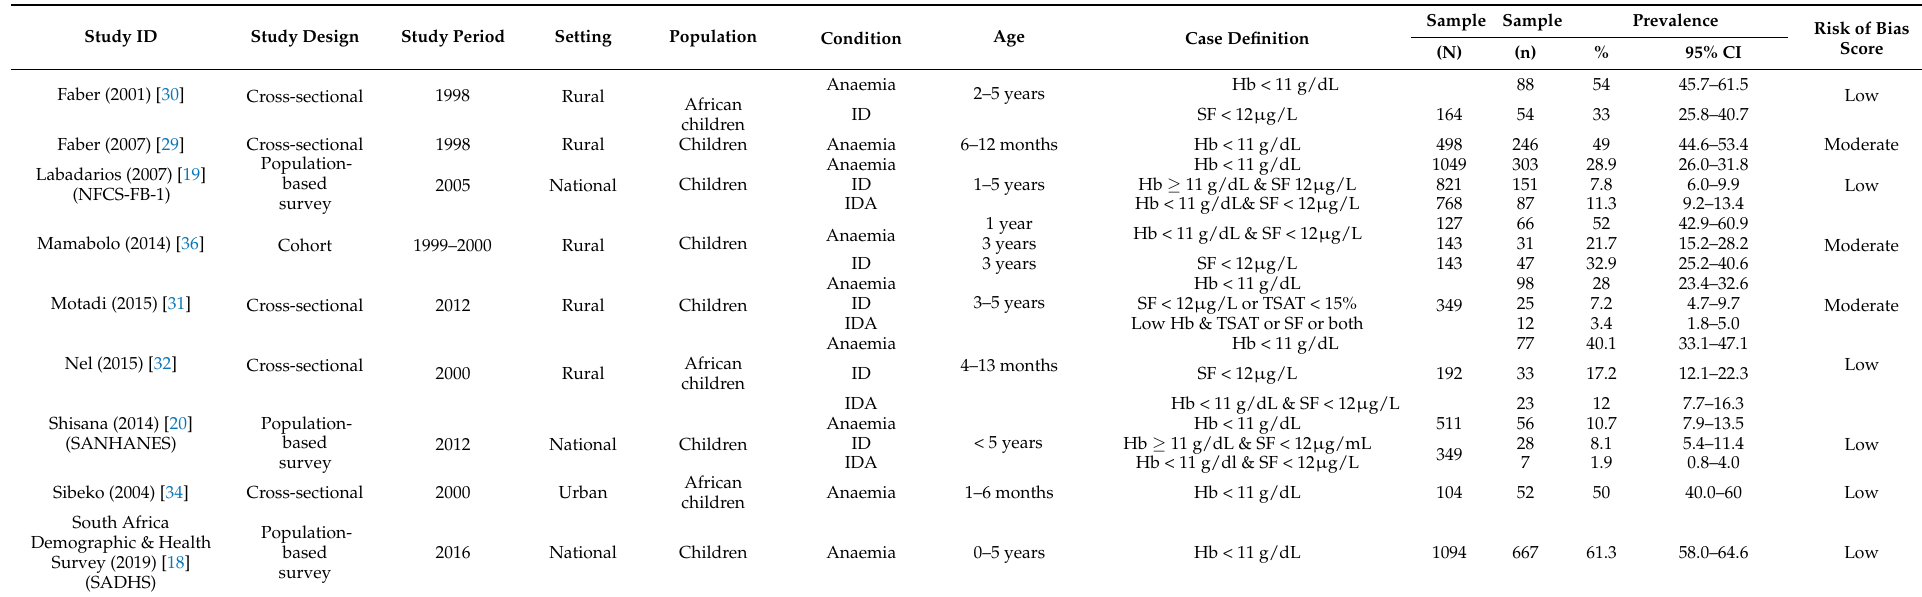
Table 2. Characteristics of included studies on anaemia, ID, and IDA for children under 5 years of age in South Africa,